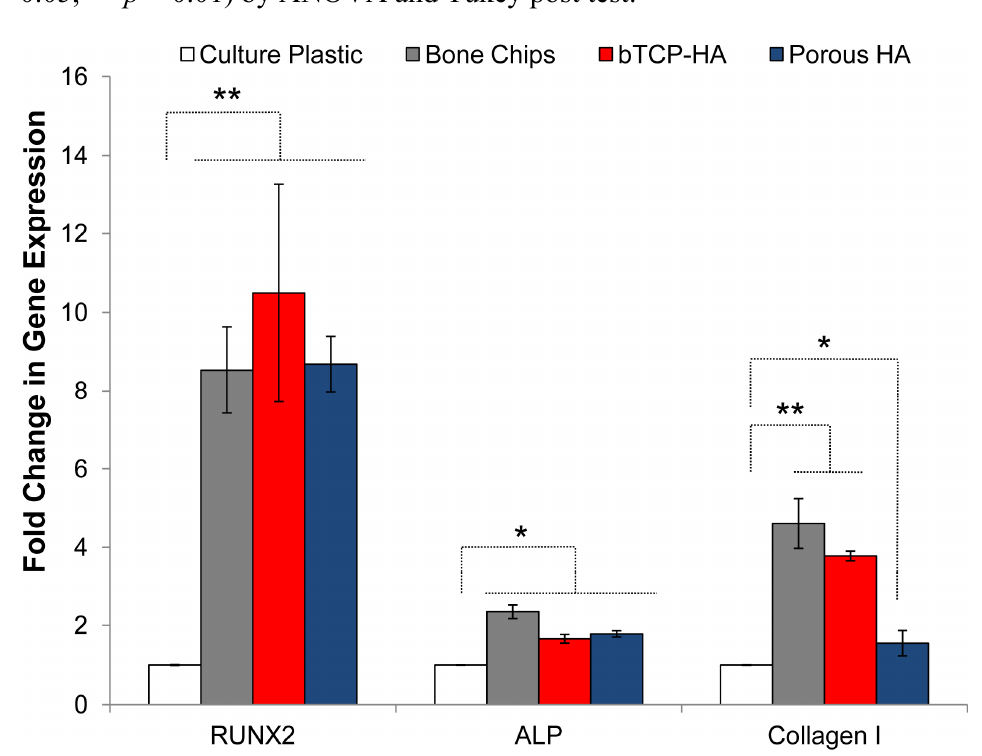
Figure 3. Relative expression of Runx2, alkaline phosphatase (ALP), and type I collagen as a fold increase over tissue culture plastic by cells incubated with cancellous bone chips, β TCP-HA, and porous HA granules after 48 h of incubation at 37 °C. Error bars represent standard error of the mean ( n = 4 per substrate). Asterisks denote significant difference ( * p < 0.05, ** p < 0.01) by ANOVA and Tukey post